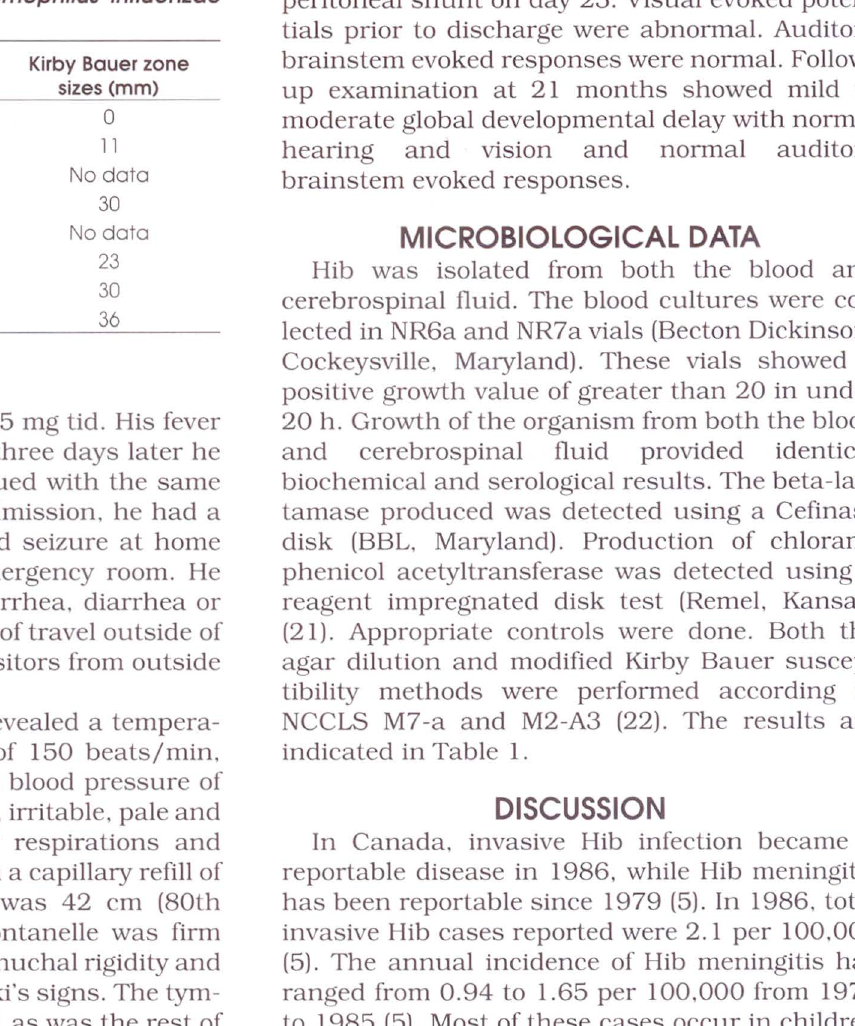
TABLE 1 Antibiotic susceptibility of an Haemophilus influenzae type b